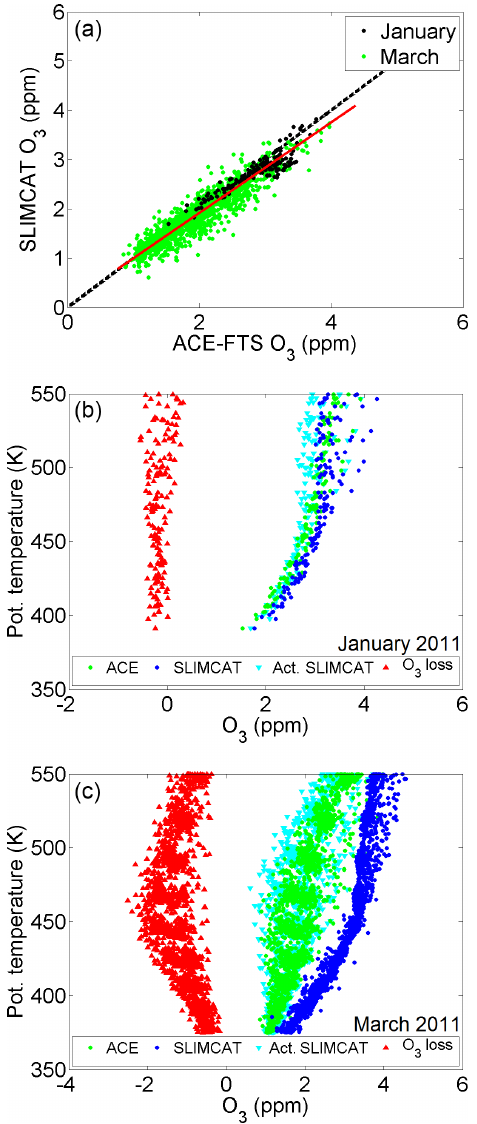
Figure 5. (a) shows a comparison between the SLIMCAT ozone and ACE-FTS ozone dataset inside the polar vortex for January (black dots) and March (green dots) 2011, with the combined re- gression fit for January and March shown as a red line. (b) and (c) show the comparison between the SLIMCAT ozone (passive ozone – SLIMCAT – shown as blue dots, and ozone with “active” chem- istry – Act. SLIMCAT – as cyan triangles) and measurements (green dots) for January 2011 and March 2011, respectively. The ozone loss is displayed as red triangles and defined as the difference be- tween the measurements and the modelled passive